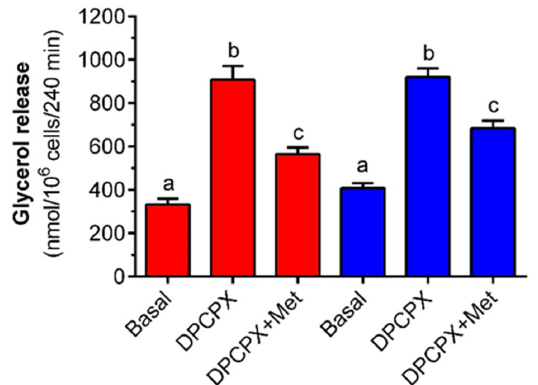
Figure 5. The effects of metformin on DPCPX-induced glycerol release in isolated rat adipocytes in the presence of low and high concentrations of glucose. Adipocytes were preincubated for 3 h with or without 1 mM metformin in the buffer containing 3 mM glucose (red bars) or 12 mM glucose (blue bars). Then, 0.5 µM DPCPX was added to all cells (except for basal) and incubations were